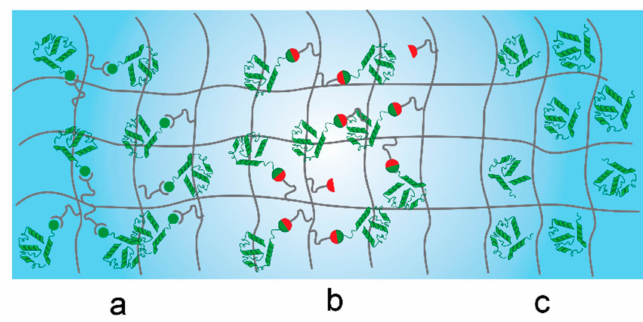
Scheme 2. Schematic representation of the most common biomolecule immobilization